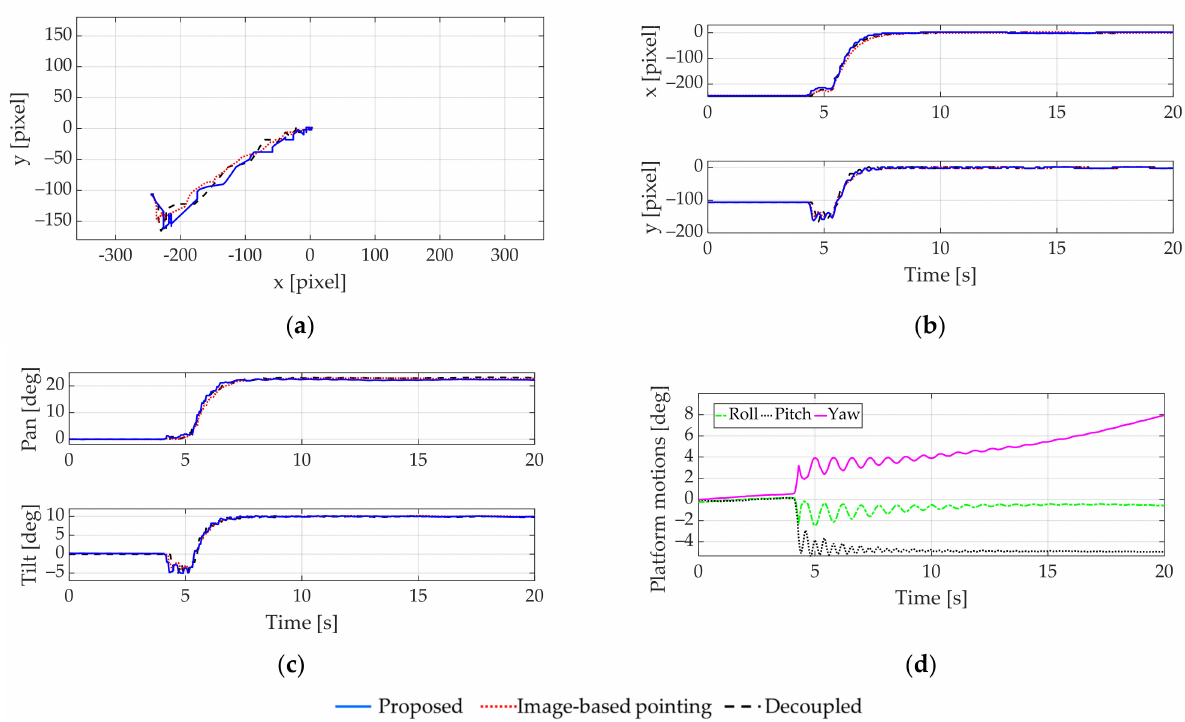
Figure 10. Experiment 3: Vision-based tracking with the presence of disturbance. ( a ) Tracking path on the image plane; ( b ) time response of each coordinate; ( c ) orientations of the inner gimbal; ( d ) disturbances from motions of the